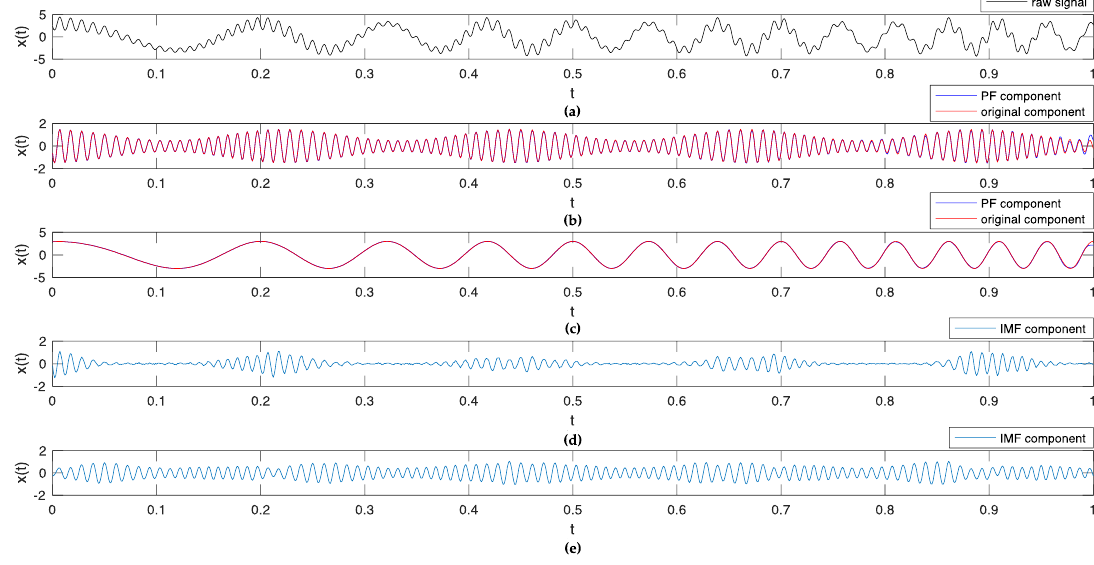
Figure 4. Results of decomposition for simulated signal.